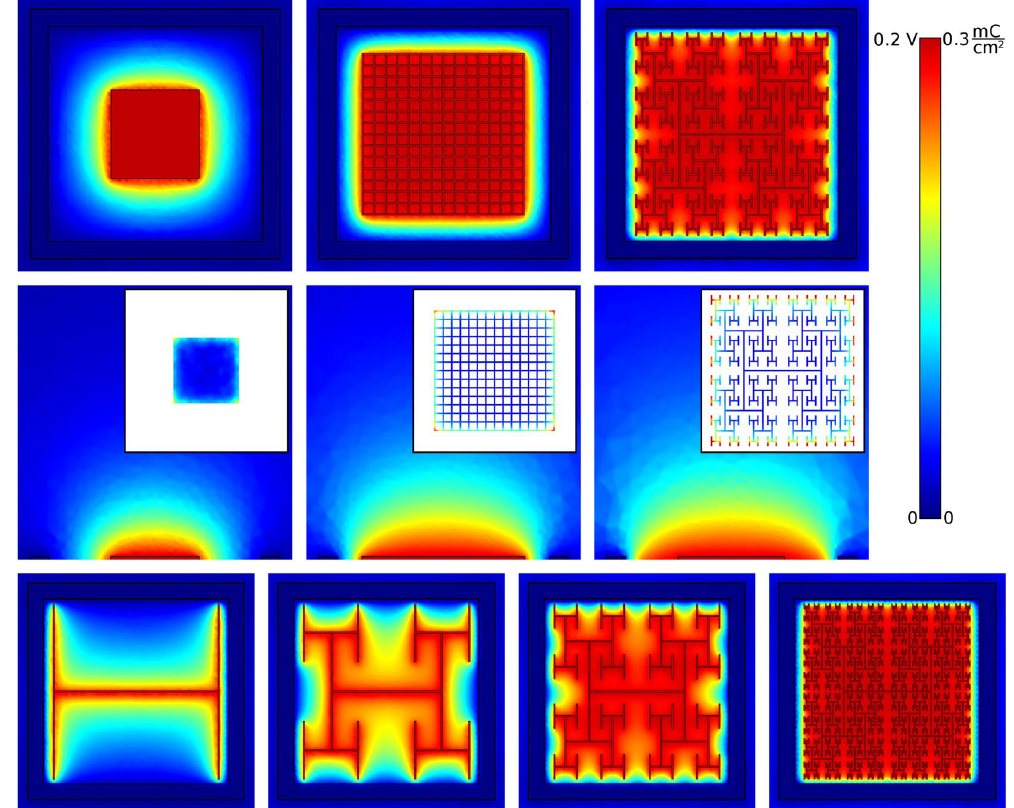
Figure 2. The maximum extracellular voltages reached during each oscillation for the square, grid, and the 3-iteration fractal electrodes (each with an electrode height of 250 nm). In each case, the applied voltage was V 0 = 0.2 V and f = 1 kHz. A horizontal slice (at the inner electrode’s top surface) of the three-dimensional voltage distribution for each electrode geometry is shown in the top row. Vertical slices through the middle of the electrodes are shown in the middle row. The charge density on the top surface of each inner electrode is shown in the insets. The bottom row shows the field uniformity achieved by increasing from 0 to 4